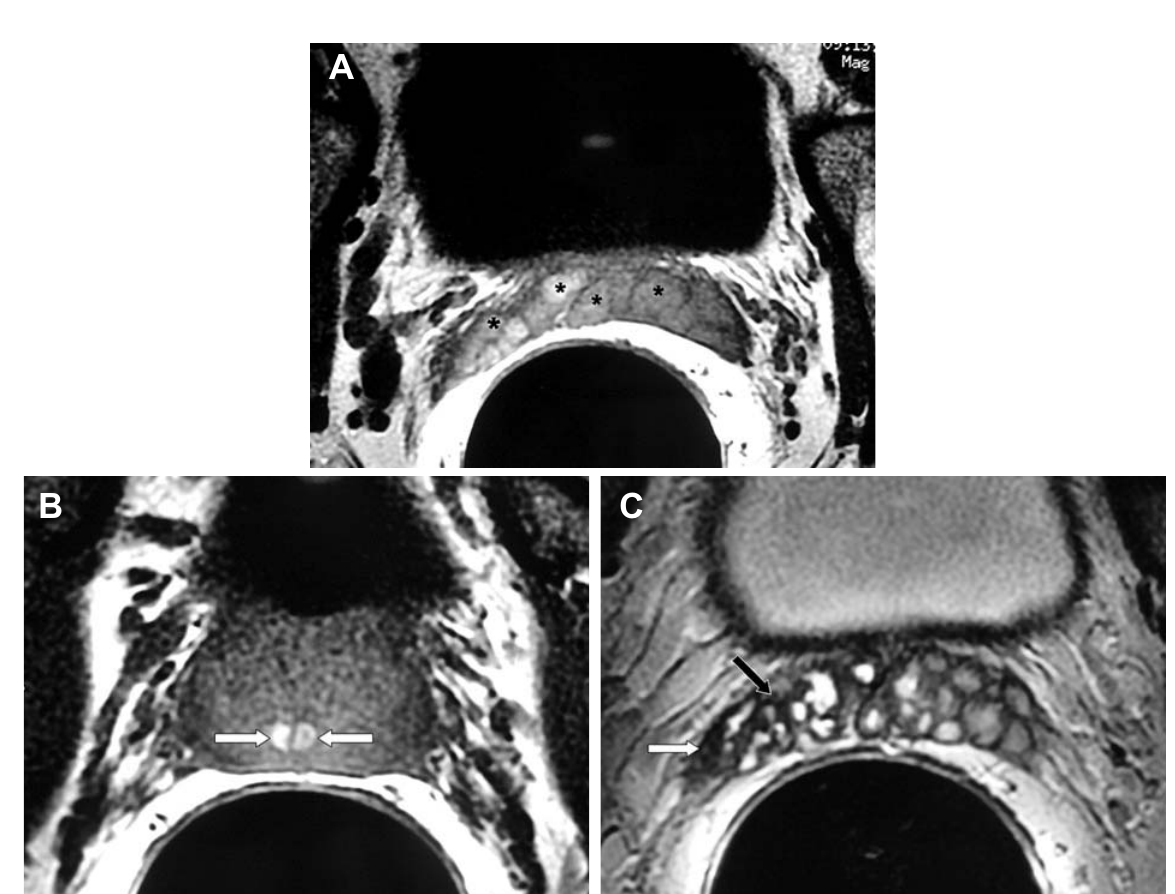
Figure 2 – Hemorrhagic chronic seminal vesiculitis. A 62-year-old man, with history of persistent hemospermia and perineal discom- fort. A) and B) E-MRI ,axial plane, T1-weighted images. Note high-signal intensity hemorrhage in both seminal vesicles (asterisk) and in both ejaculatory ducts (white arrows). C) and D) E-MRI, axial plane, T2-weighted images ,showing imaging features consistent with chronic seminal vesiculitis: diffuse thickening of the of the seminal vesicles with low T2-weighted signal intensity (dark arrow) and loss of convolutions( white arrow).These abnormalities are more evident in the right seminal vesicle which appeared contracted in comparison with the left seminal